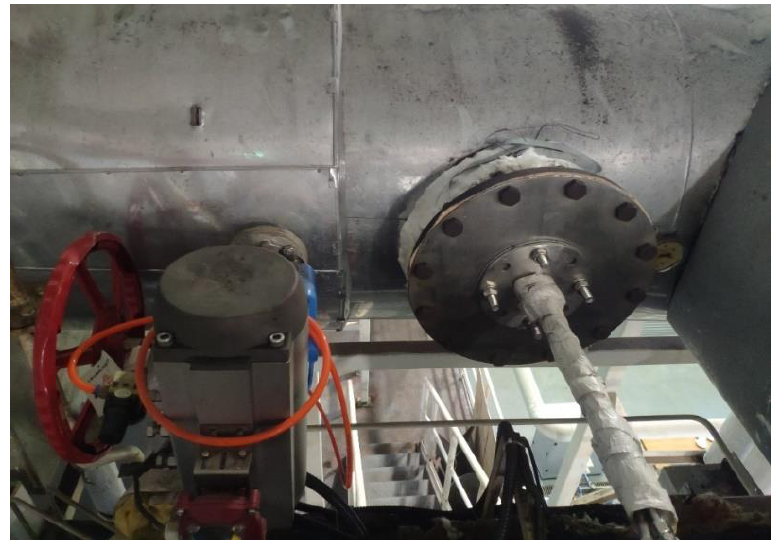
Figure 4. Sampling port of the chimney channel.